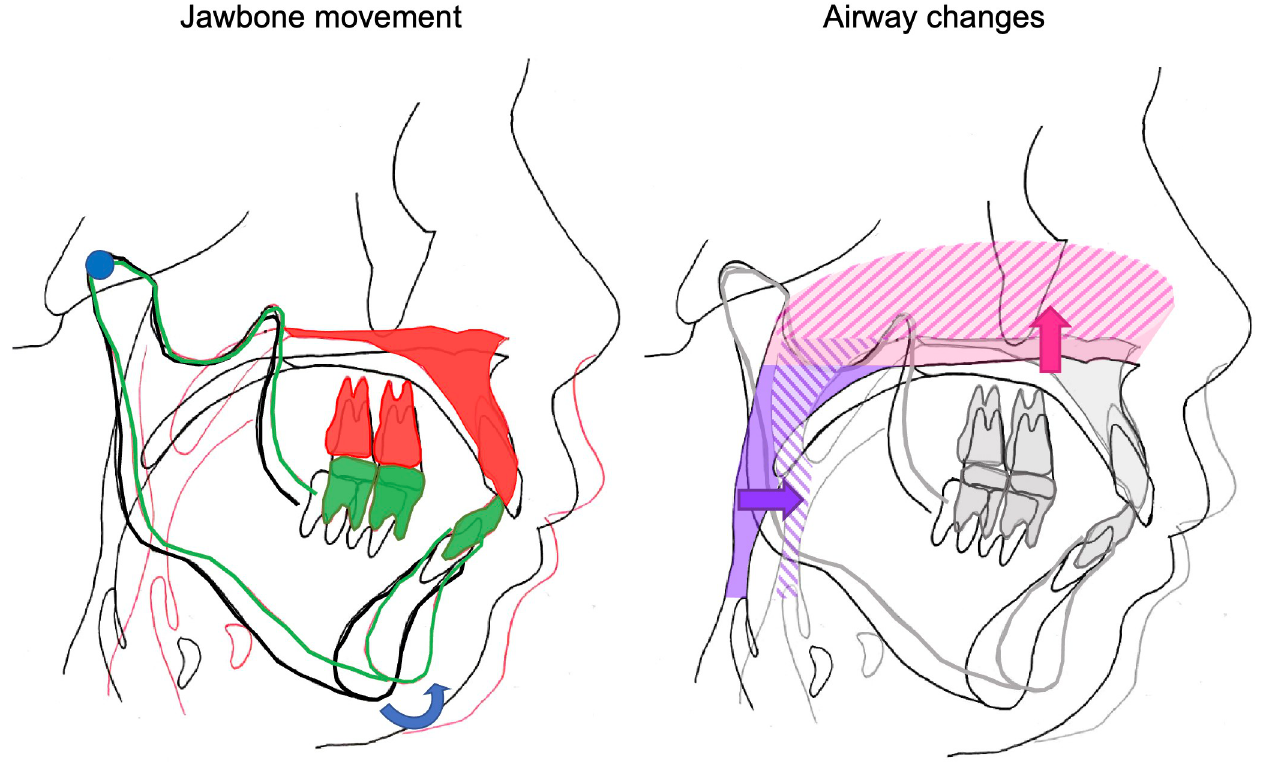
Fig 1. Postero-superior repositioning of the maxilla and mandibular autorotation. Surgical impaction of the maxilla and the reaction of the mandible and the associated changes in the airway are illustrated schematically. Notes: black line, pre-surgery (before mandibular autorotation); red line, post-surgery; blue circle, center of mandibular autorotation; blue arrow, direction of autorotation; green line, after mandibular autorotation; gray line; post-surgery in the figure of airway changes; pink area, preoperative nasal cavity; pink hatched area, postoperative nasal cavit; pink arrow, direction of nasal cavity change; purple area, preoperative nasopharyngeal airway; purple hatched area, postoperative nasopharyngeal airway; purple arrow, direction of pharyngeal change.